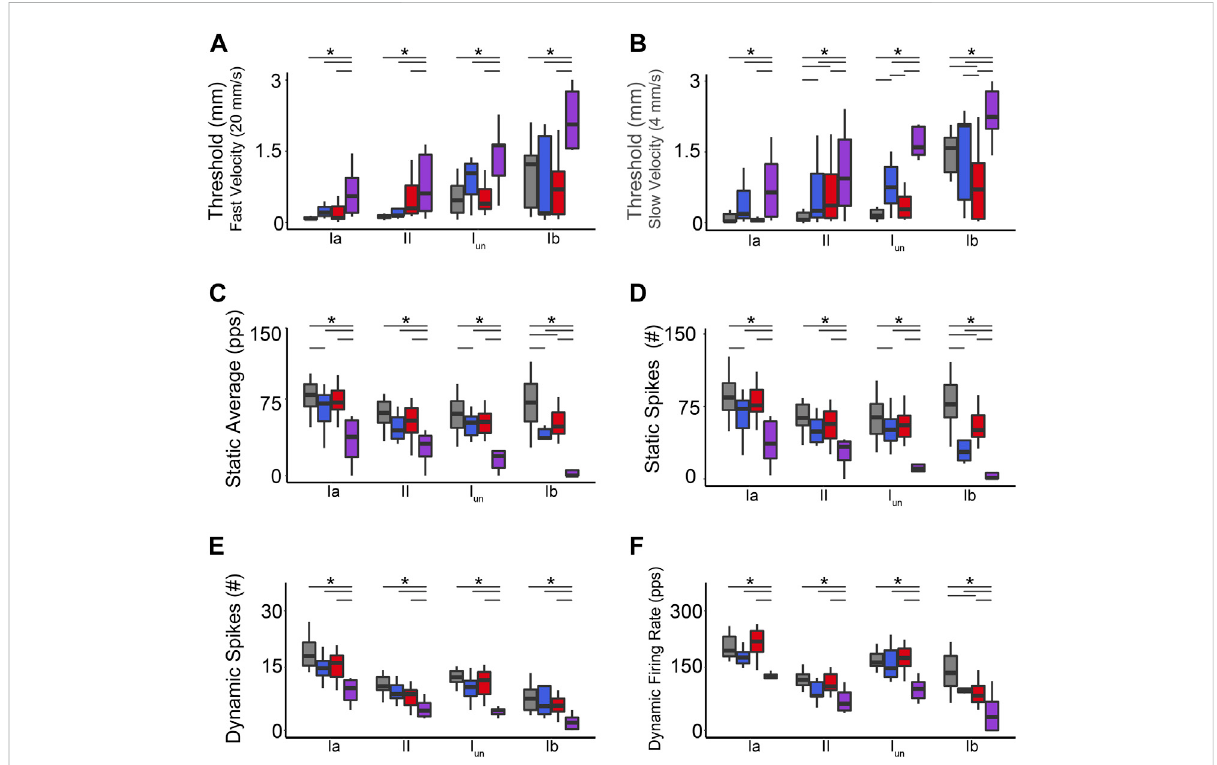
FIGURE 2 Co-Impairment of Key Muscle Mechanosensory Features. Quanti fi cation of clusters of encoding parameters: detection threshold: during fast (A) and slow (B) stimuli, static average (C) , number of spikes during static (D) and dynamic stimuli (E) , and peak dynamic fi ring rate (F) , averaged from four trials, from each neuron in each of the neuronal classes. * indicates statistically signi fi cant differences as empirically derived from hierarchical Bayesian model (stan_glm): 95% highest density intervals do not